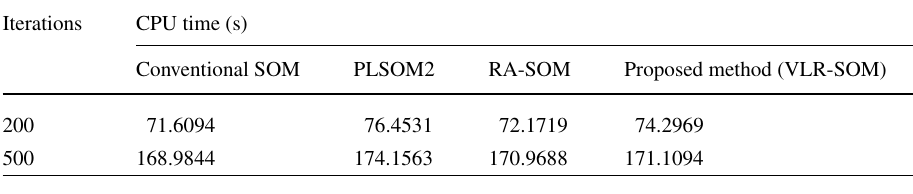
Table 9 Dataset used for experiments in this study S. No Data set Samples